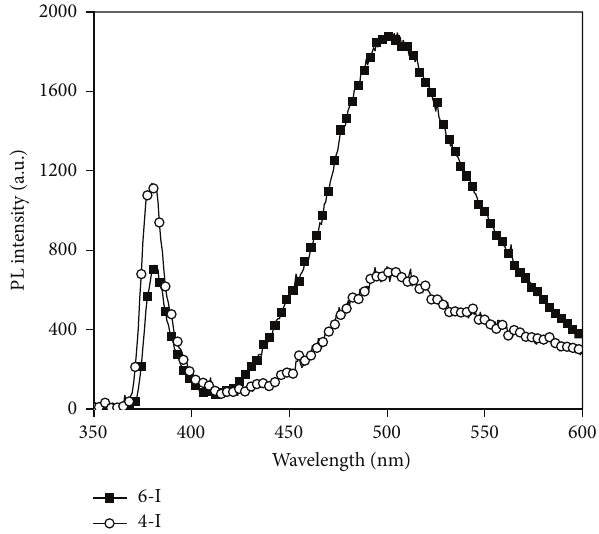
Figure 4: PL spectrum of ZnO thin films prepared using a spray solution of different